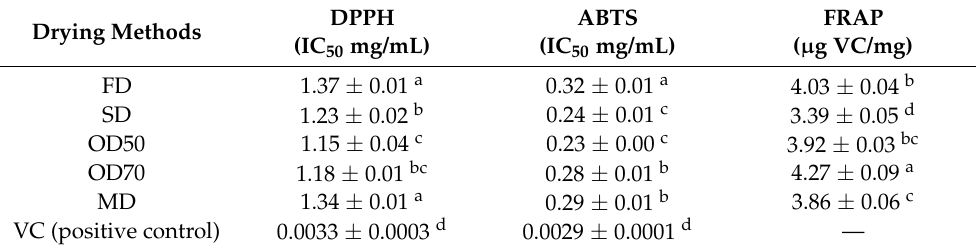
Table 3. Antioxidant capacity of extracts from the navel orange peels dried by different methods via DPPH, ABTS, and FRAP